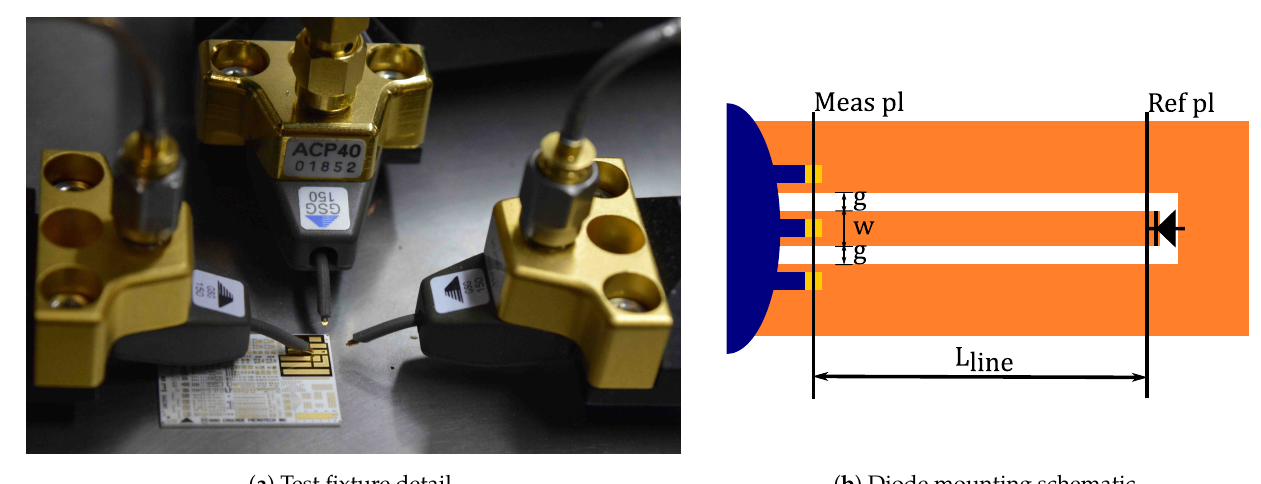
Figure 2. X-parameters measurement